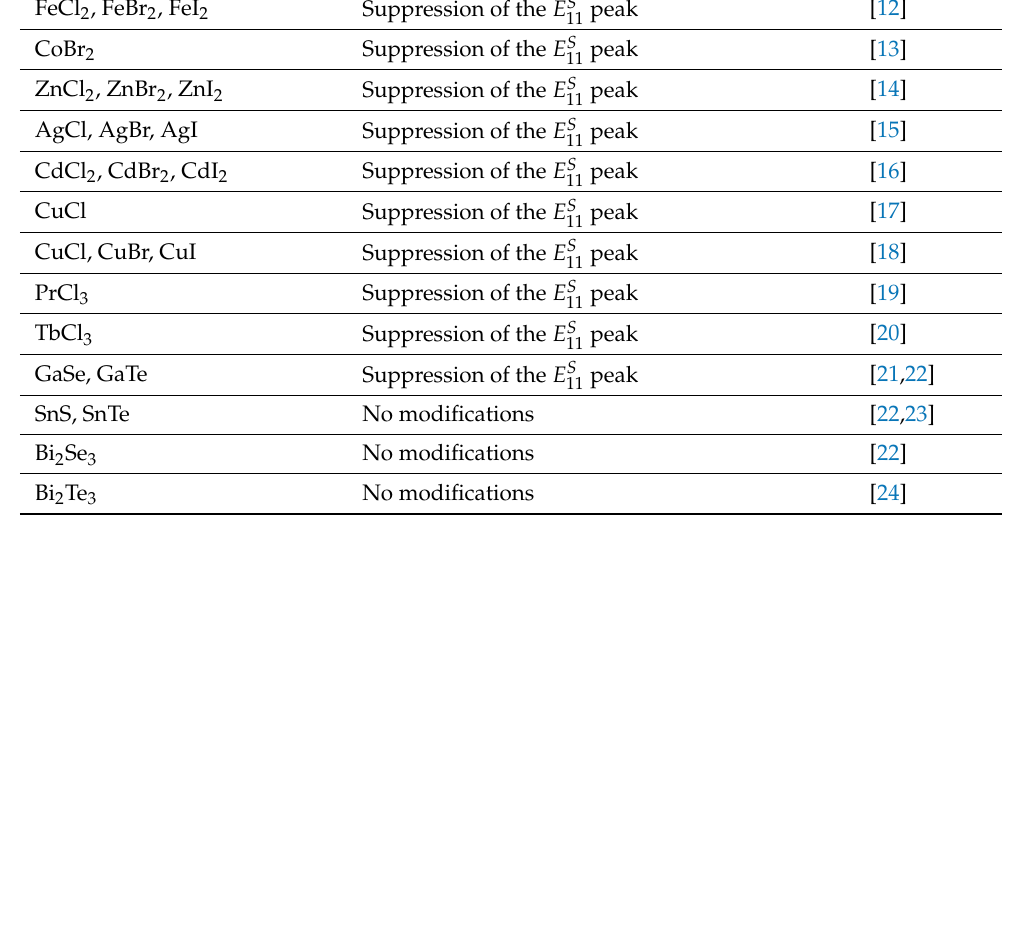
Table 1. Summary of doping-induced modifications of the OAS spectra of filled SWCNTs. Filled